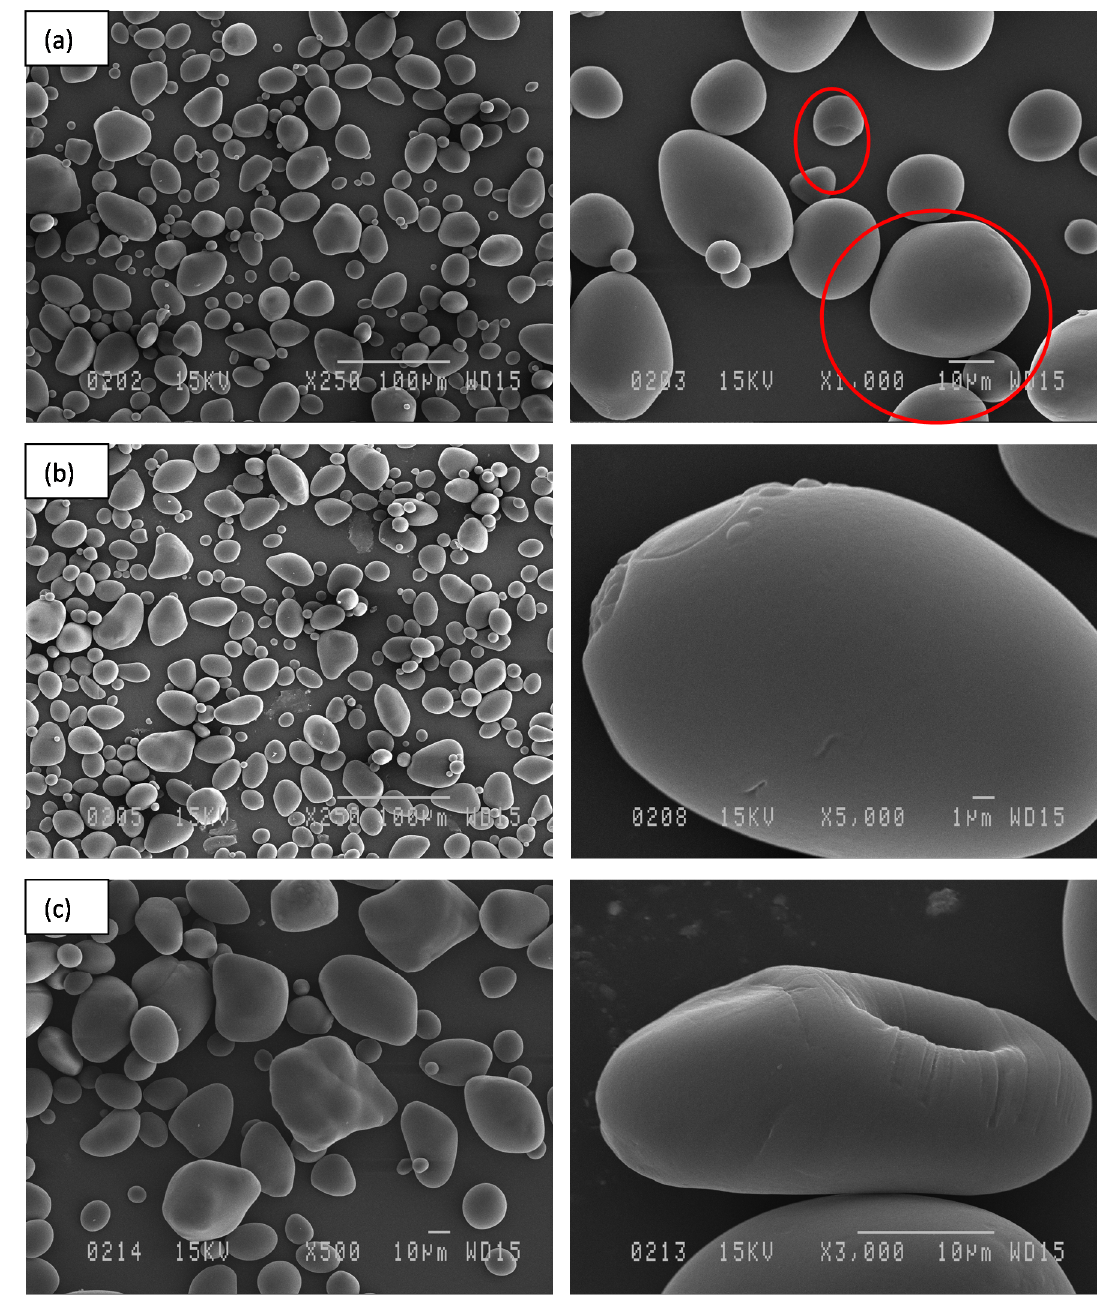
Figure 3. SEM images of potato starch treated with ( a ) liquid CO 2 (irregular shapes of granules are circled in red); ( b ) supercritical CO 2 at 40 °C; ( c ) supercritical CO 2 at 70 °C.